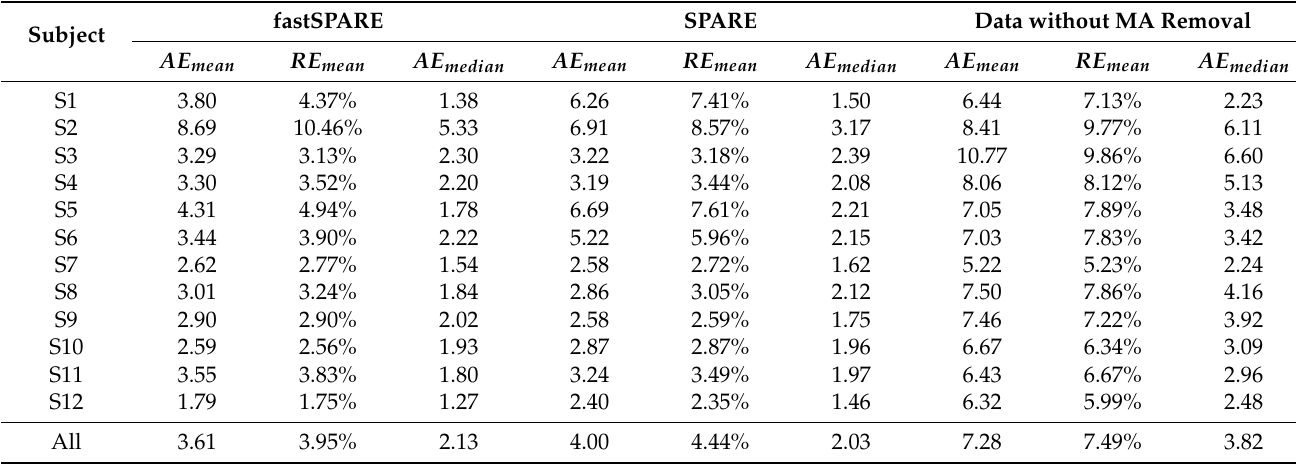
Table 2. Evaluation of SPARE and fastSPARE by comparing heart rate error (BPM) from ECG (RR-intervals) and PPG (PP-intervals) on windows of 8 s.